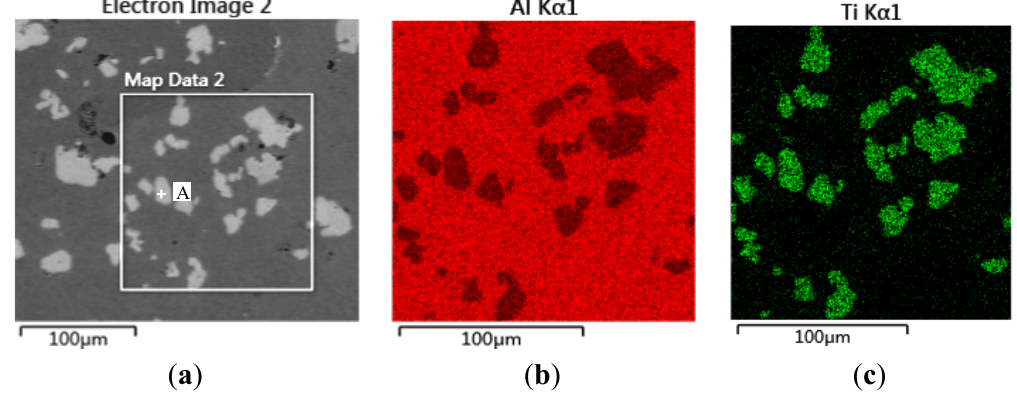
Figure 2. High power SEM image of Figure 1a and elemental maps and EDS analysis of master alloy 1 # with blocky TiAl particles: ( a ) SEM image; ( b ) Al element; ( c ) Ti 3 element; ( d ) EDS analysis of point A in Figure